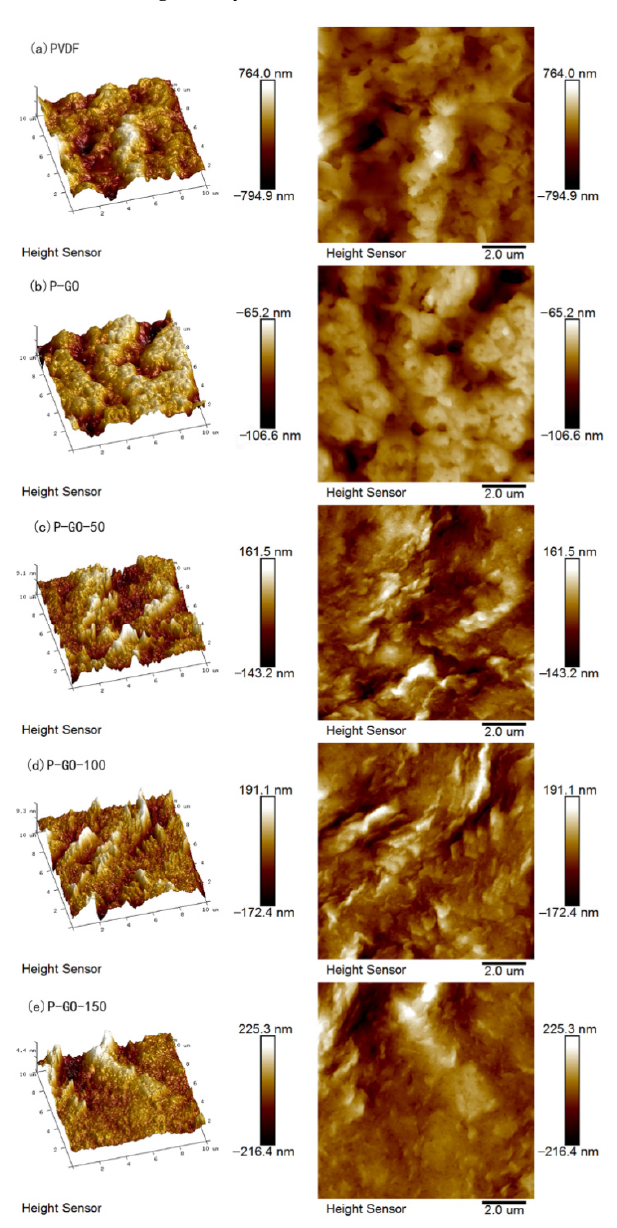
Figure 6. AFM images of various membranes.